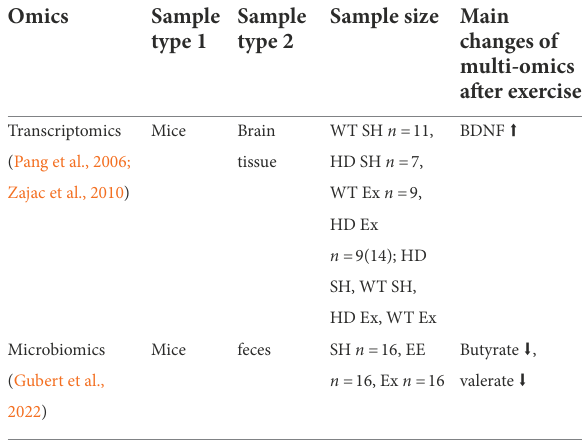
TABLE 3 Multi-omics studies of exercise and HD.